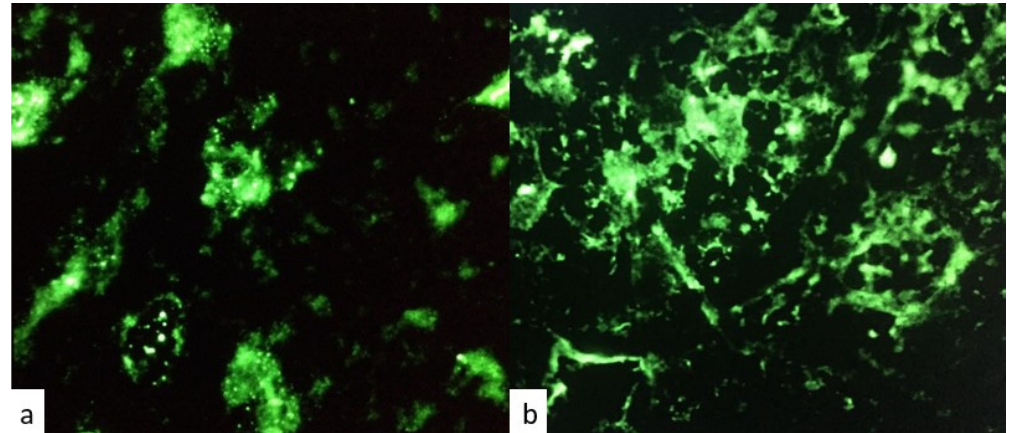
Figure 2. Immunofluorescence patterns for ( a ) positive anti-pituitary antibodies (APA) and ( b ) negative anti-pituitary antibodies (APA).